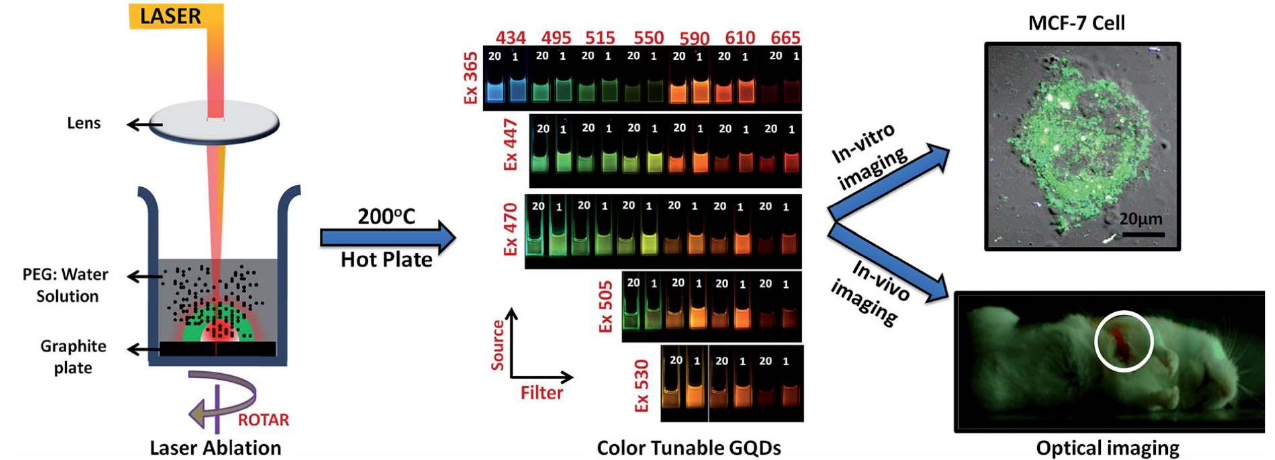
Figure 36. GQDs exhibiting color-tunable emission. [109]